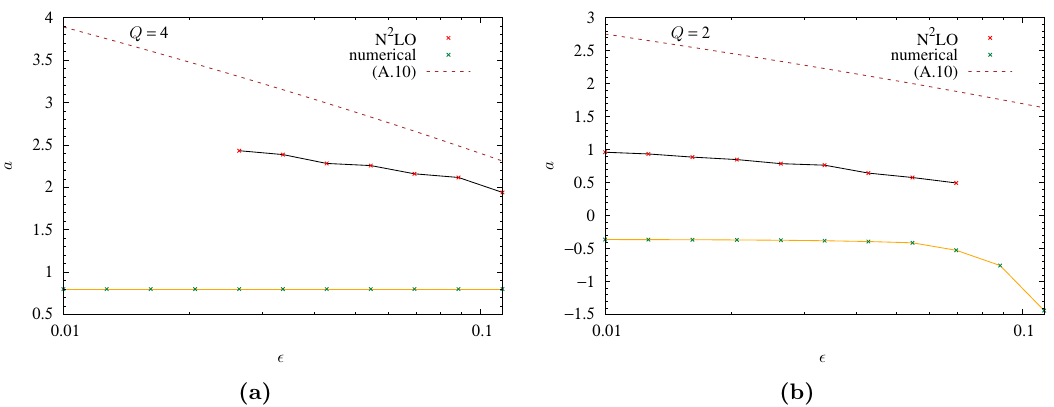
Figure 16. Separation distance 2 a between (a) two N = 2 and (b) two N = 1 baby Skyrmions as a function of (cid:15) . The semianalytic method to order N 2 LO is shown with red crosses and the full numerical brute-force computation of figure 5 is shown with green crosses. For comparison, the compacton radius R of eq. (A.10) is shown with a brown dashed compacton